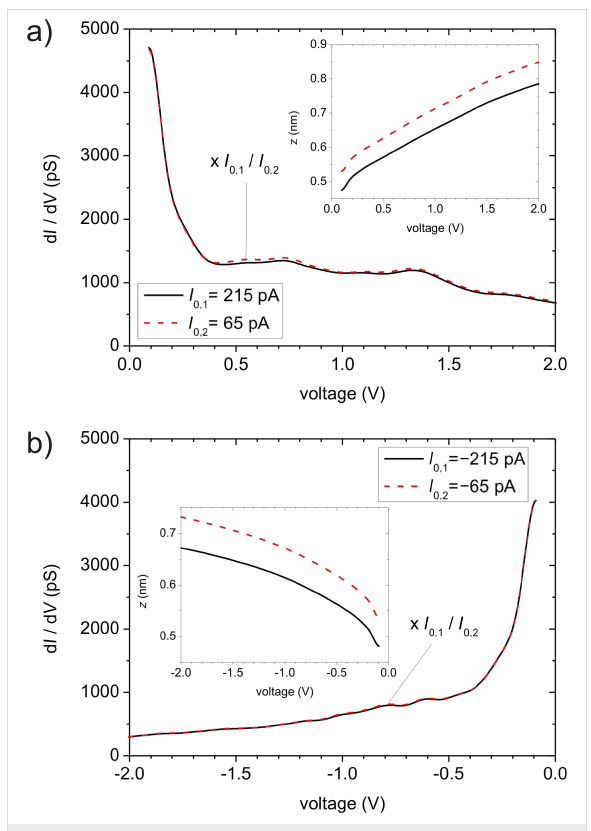
Figure 3: ∂ V I-V curves measured on Nb(110) a) in the positive bias range at two different set currents ( I 0,1 = 215 pA and I 0,2 = 65 pA), and b) in the negative voltage range at I 0,1 = − 215 pA and I 0,2 = − 65 pA. The insets depict the corresponding z ( V )– V curves, which were measured simultaneously. ( φ = 4.1 eV). The given values of the set currents are the averages of the tunneling current during the measure- ment at an accuracy of